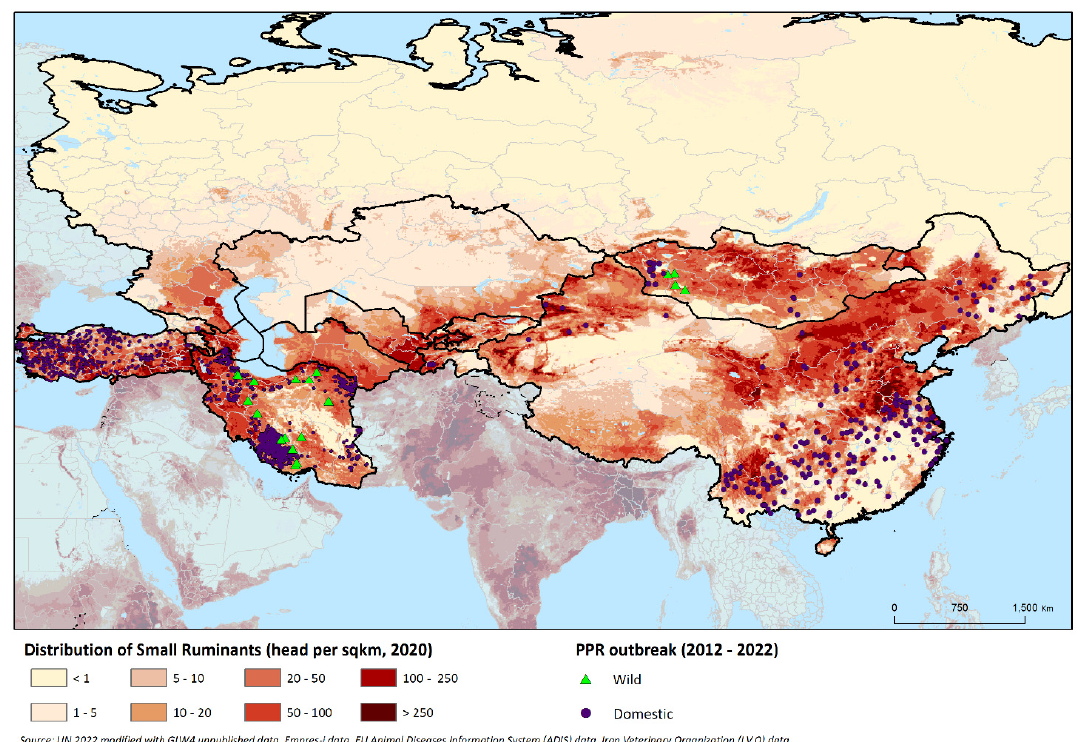
Figure 1. Map of the region showing the distribution of domestic SR (sheep and goats) at the subregional level (adjusted to FAOSTAT population figures for 2020) and the location of reported PPR outbreaks that occurred between 2012 and 2022 in domestic and wild animals. PPR outbreak data were obtained from EMPRES-i [25], from EU-ADIS (for Turkey) [26] and through the Iran Veterinary Organization (for the Islamic Republic of Iran) [27]. The density of domestic SR (head per square km) is indicated by the colour shading, and PPR outbreaks in domestic and wild animals are denoted by purple dots and green triangles, respectively.